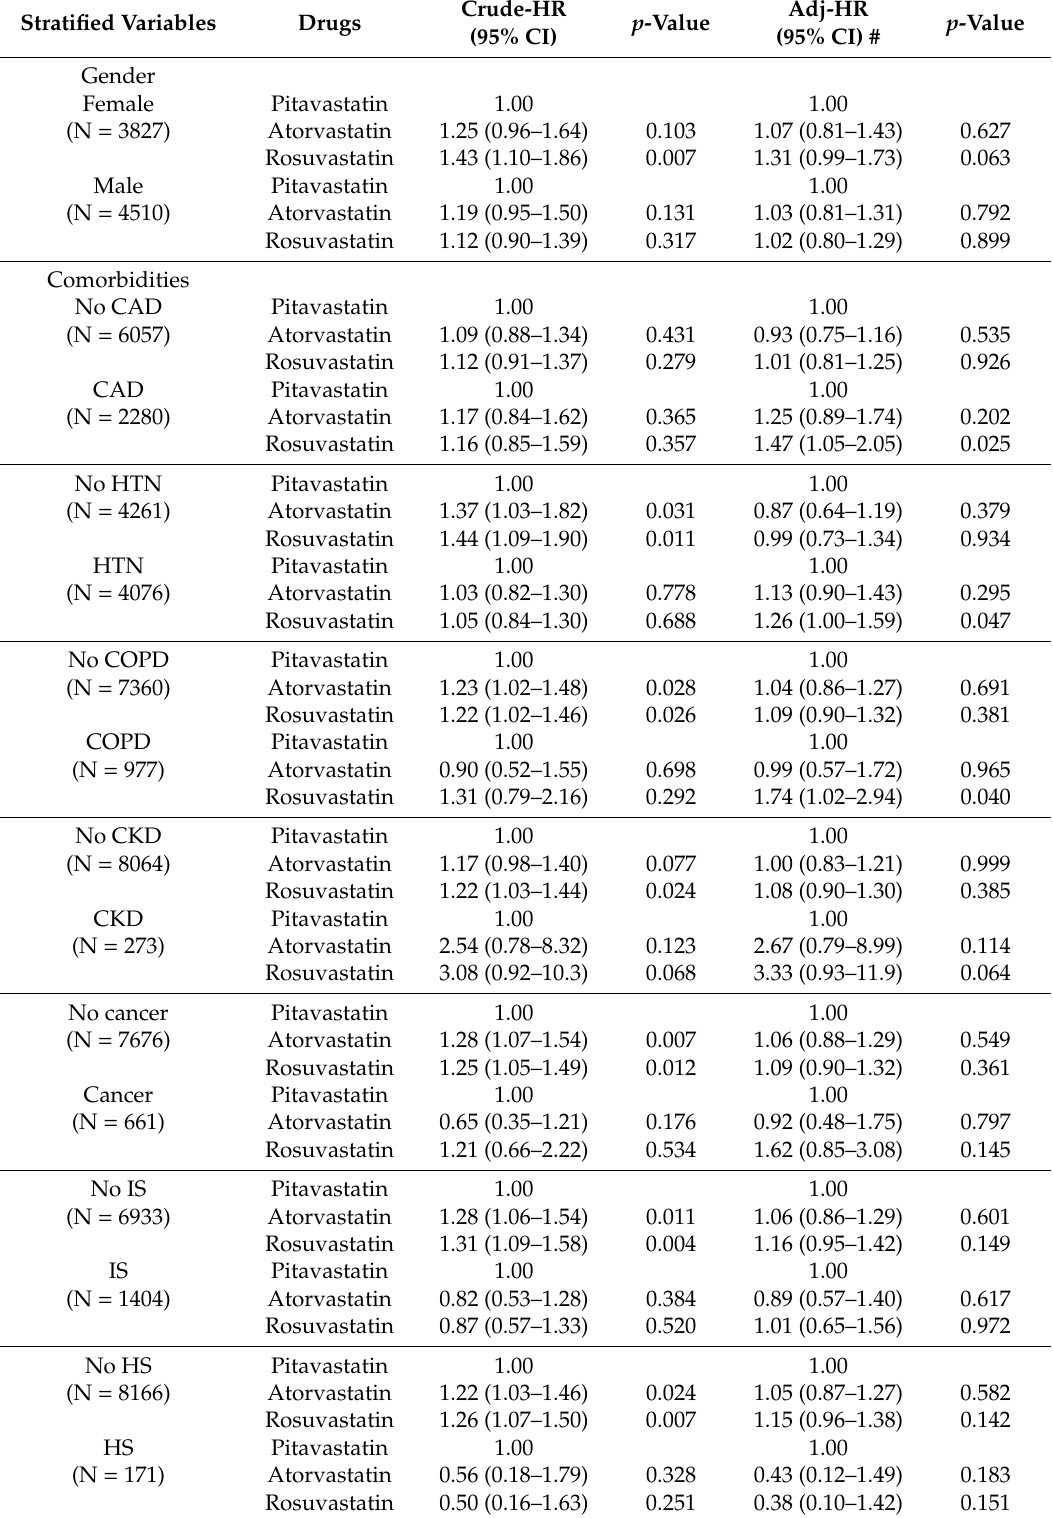
Table 4. HR of three statin groups in NODM stratified with baseline